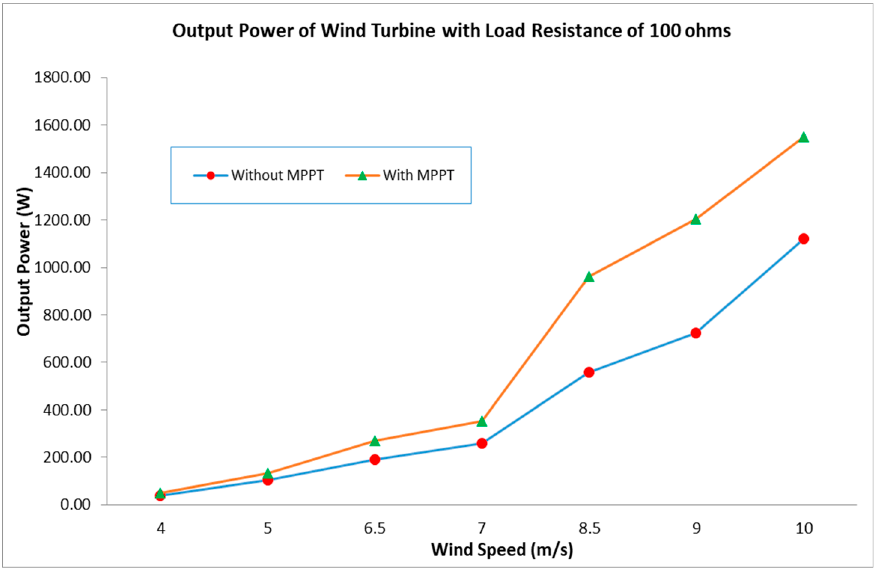
Figure 15. Output power of wind-turbine system with load resistance of 100 Ω .